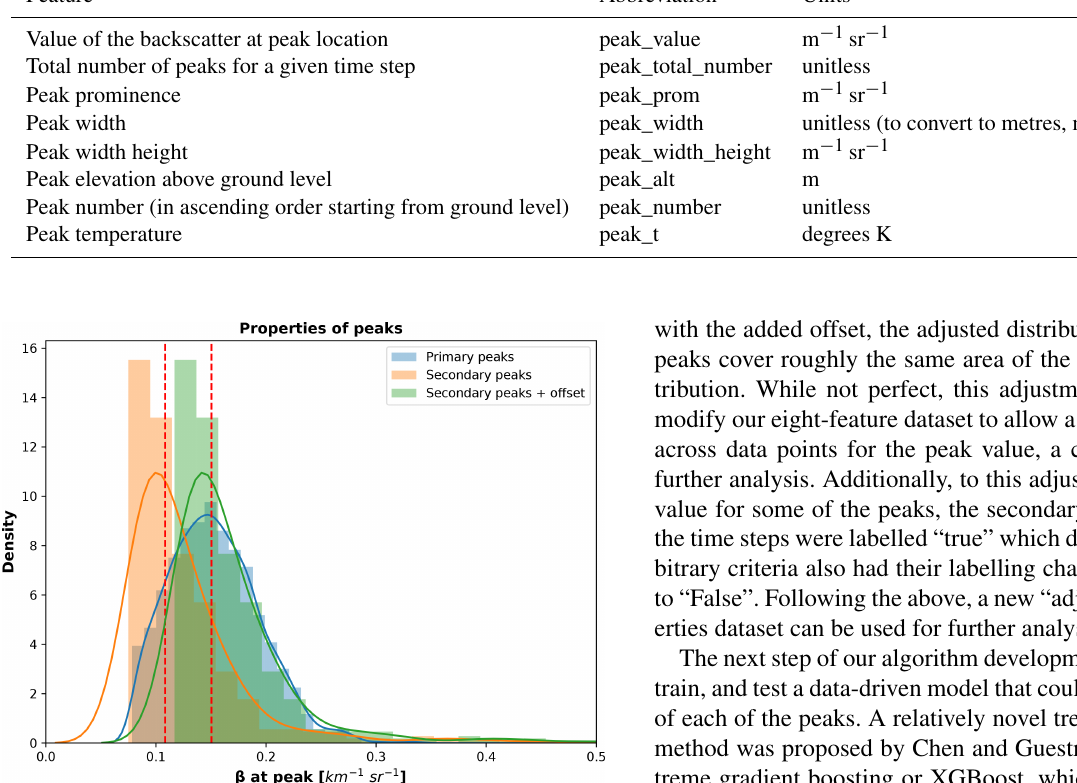
Figure 3. Distributions and kernel density estimates of values of attenuated backscatter for identified peaks. Primary peaks are la- belled in blue (3727 data points), while profiles including secondary peaks (peak numbers equal to 2, 3, or 4) are shown in orange (570 data points, including 539 data points with a peak number of 2, 26 data points with a peak number of 3, and 5 data points with a peak number of 4). Vertical dashed red lines indicate the median values of primary and secondary peak distributions. Adjusted secondary peaks (secondary peak attenuated backscatter values plus offset) are shown in